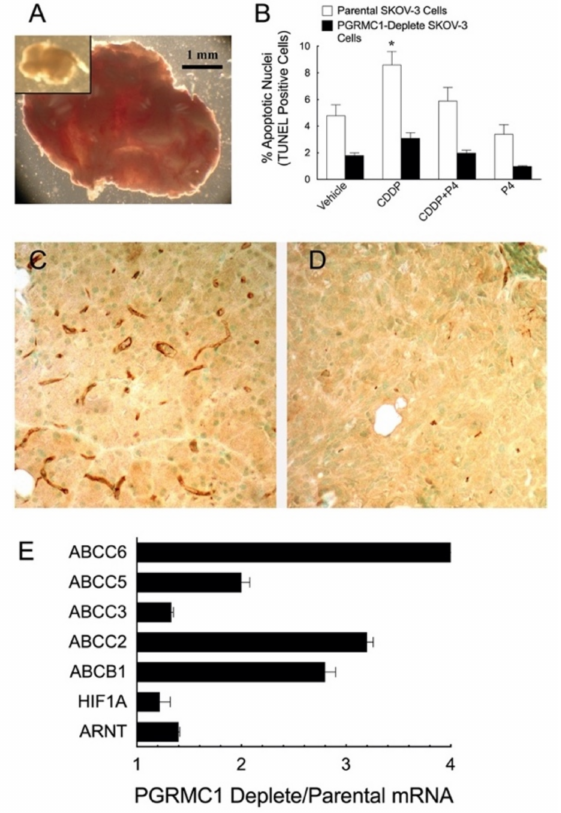
Figure 3. Comparison of xenograft tumor growth in PGRMC1-intact and PGRMC1-deplete dsRed-SKOV-3 cells. Panel A shows a typical tumor derived from PGRMC1-intact dsRed-SKOV-3 cells, while a typical tumor derived from PGRMC1-deplete dsRed-SKOV-3 cells is shown in the in- set of panel A . Images are shown at the same magnification (Peluso, unpublished data). The effect of cisplatin (CDDP 8 mg/kg body weight, i.p.) and P4 (1 mg/0.1 mL of oil, s.c.) on the percentage of apoptotic nuclei is shown in B . * indicates a significant difference from con- trol ( n = 24 to 65 tumors/treatment; p < 0.05). The microvasculature of tumors derived from PGRMC1-intact ( C ) and PGRMC1-deplete ( D ) dsRed-SKOV-3 cells is revealed by staining for the endothelial cell marker, CD31 (brown stain). ( E ) Expression of ARNT, HIF1A, and several ABC transporters are shown as a ratio of the mRNA levels in PGRMC1-deplete to PGRMC1-intact ovarian tumors. All changes in mRNAs are statistically significantly different ( n = 4; p < 0.05). Images and graphs taken from Figure 6 of the article by Peluso et al. [4] with permission from CCC